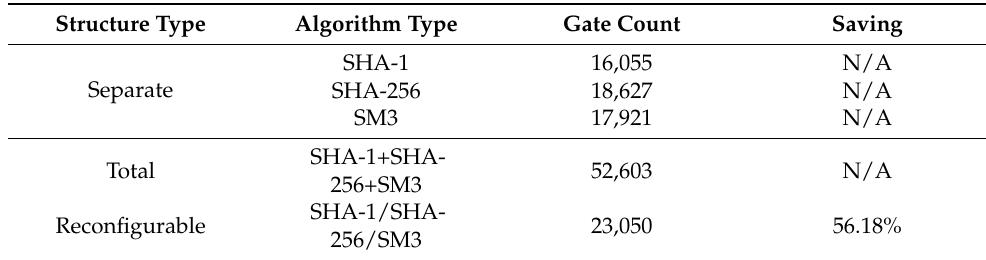
Table 7. Hardware overhead of separate hardware implementation and reconfigurable implementa- tion of the three hash functions in 65 nm.